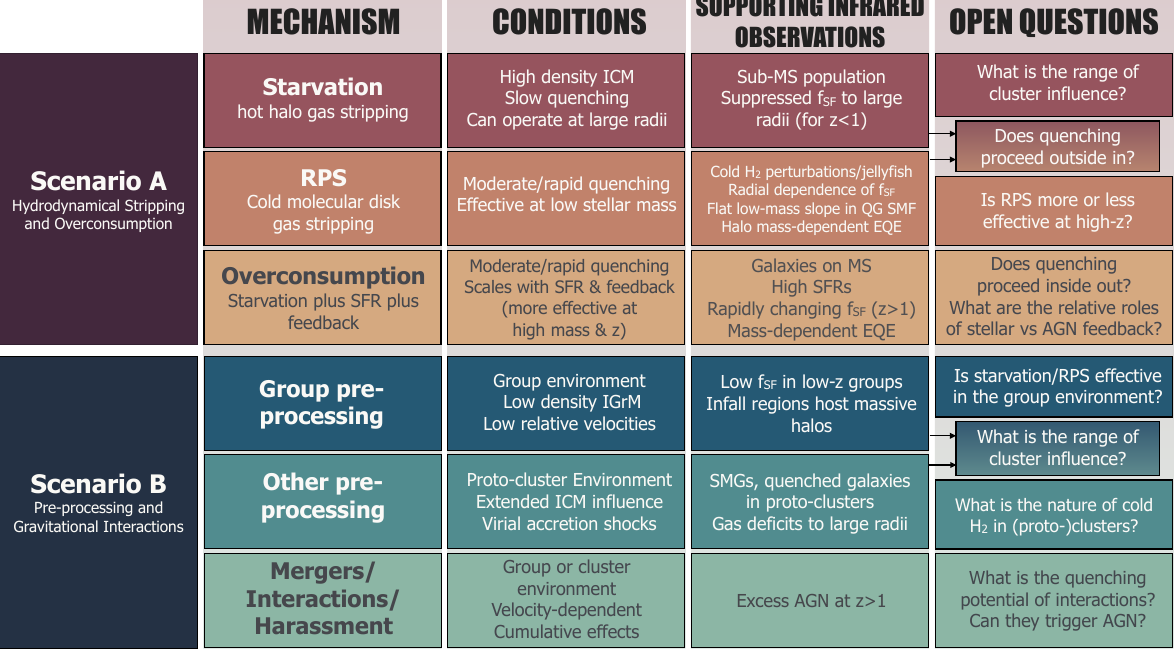
Figure 19. A tabulated list of the primary quenching mechanisms that fall within the scenarios outlined in Section 8, along with their respective signatures, some of the more robust lines of supporting evidence from infrared studies, and open